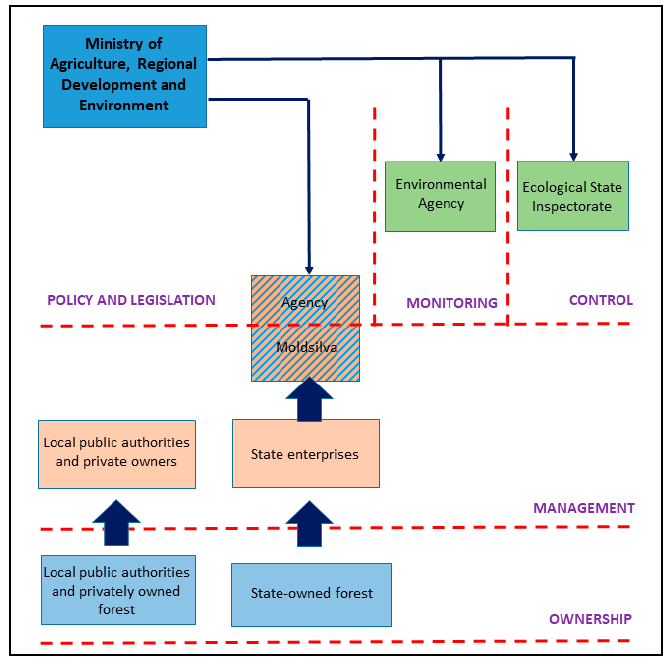
Figure 1. Institutional framework of the forest sector in the Republic of Moldova.